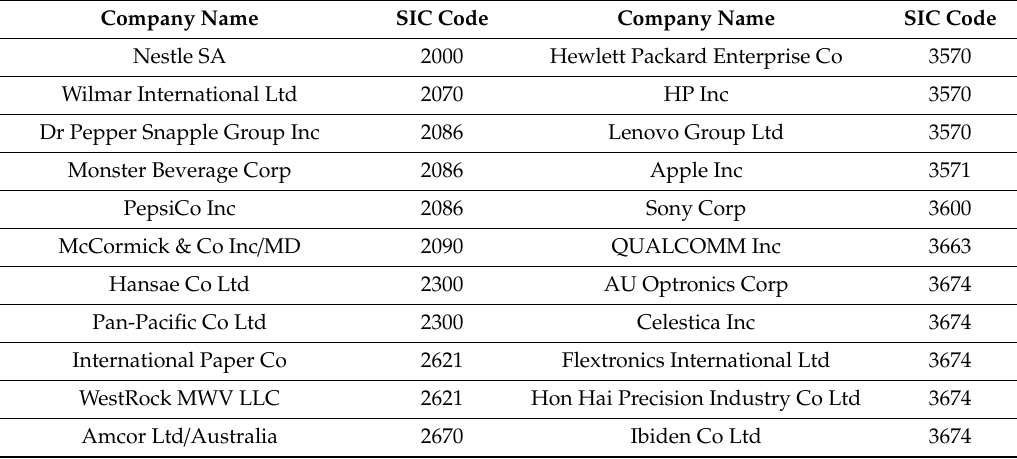
Table A2. Supplier firms and four-digit SIC codes (after